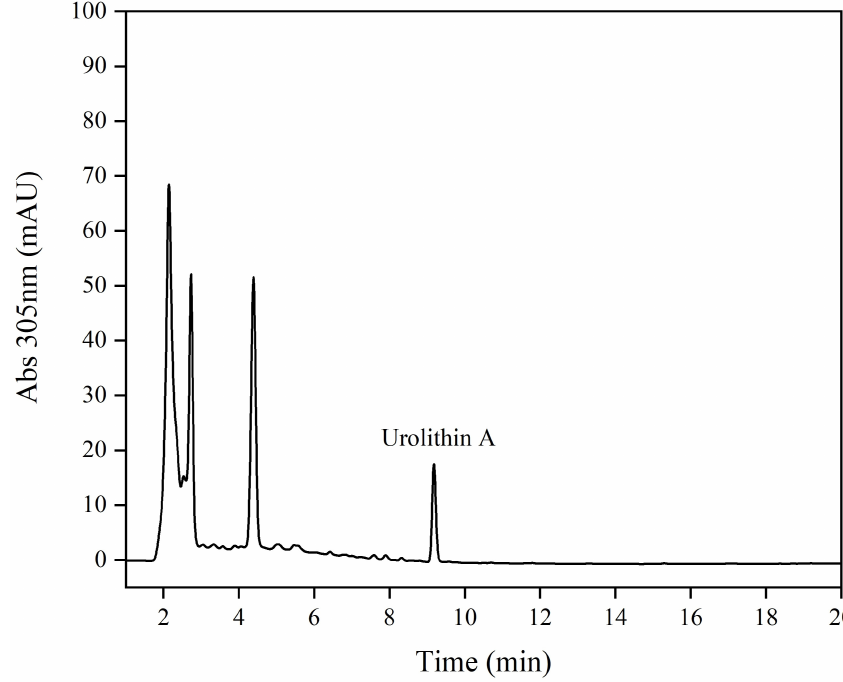
Figure 2. HPLC analysis of the fermentation broth of the strain FUA329.